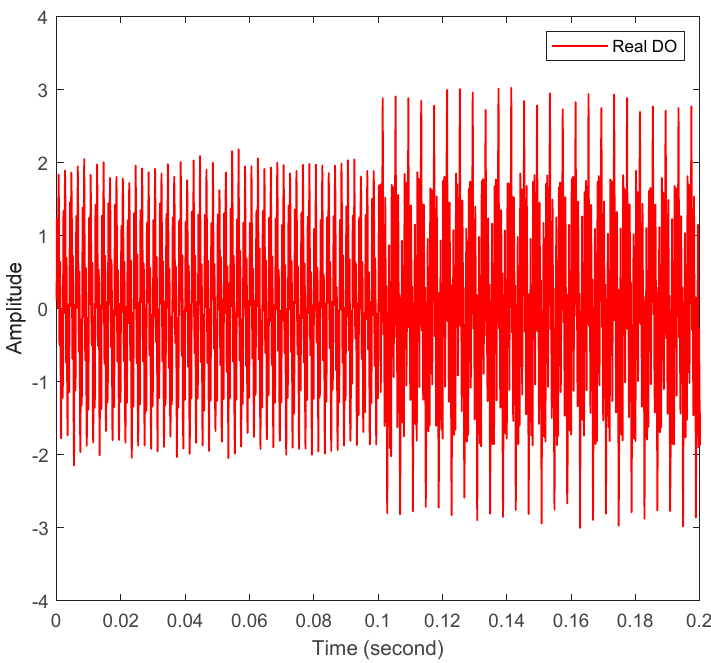
Figure 4. Decomposition by EEMD illustrating 8 out of 8 intrinsic mode functions (IMFs).